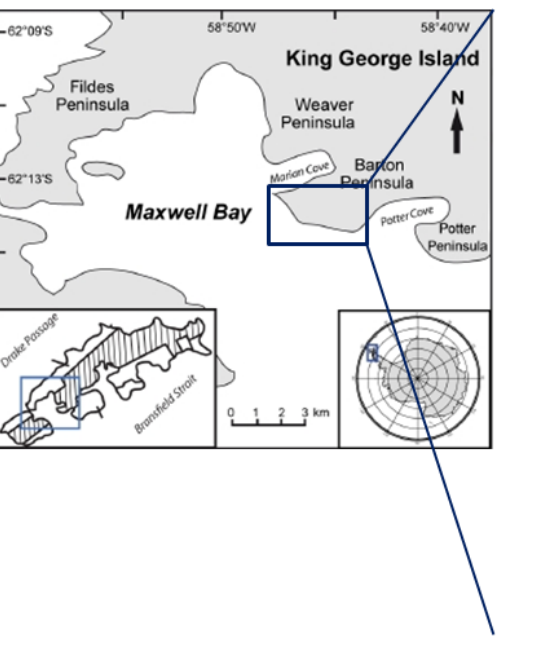
Figure 3. Collection site of Chinstrap penguin carcasses. Dead Chinstrap penguins were collected at Narębski Point (Antarctic Specially Protected Area; ASPA No. 171, red circle) on King George Island,